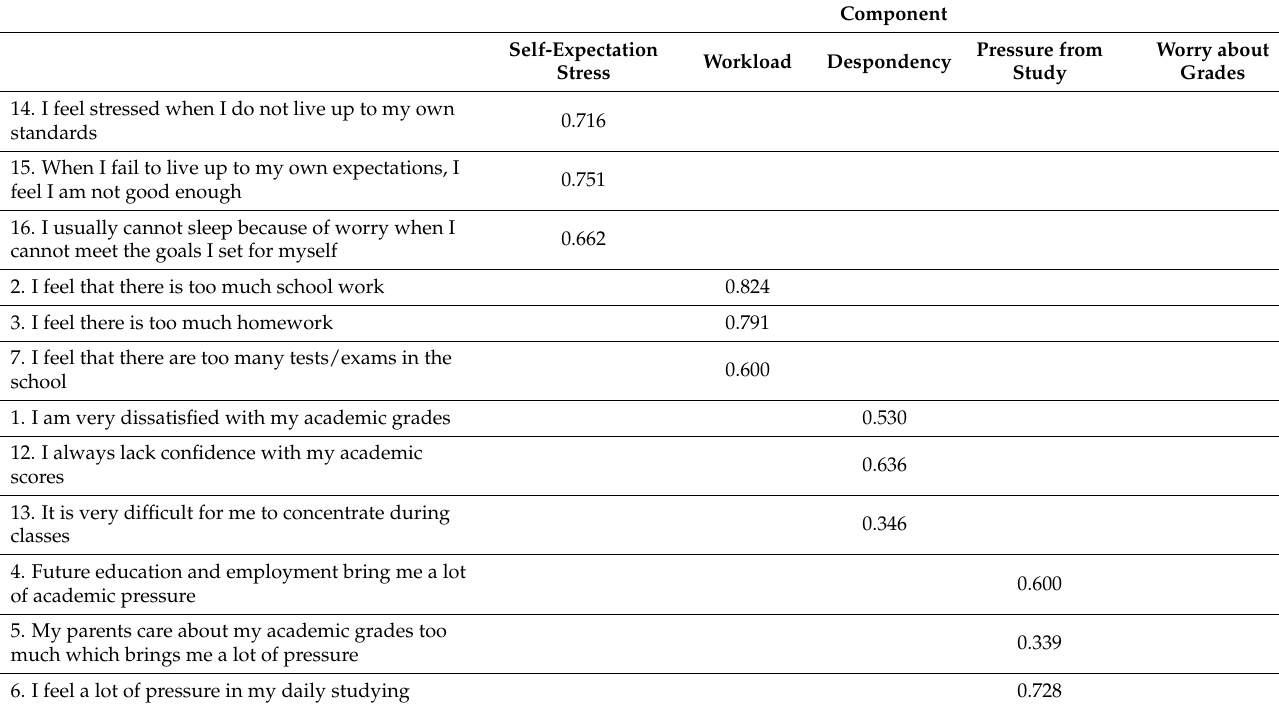
Table 3. Rotated factor loadings: Exploratory Factor analysis (EFA) results regarding the ESSA questionnaire’s 16 items (N =